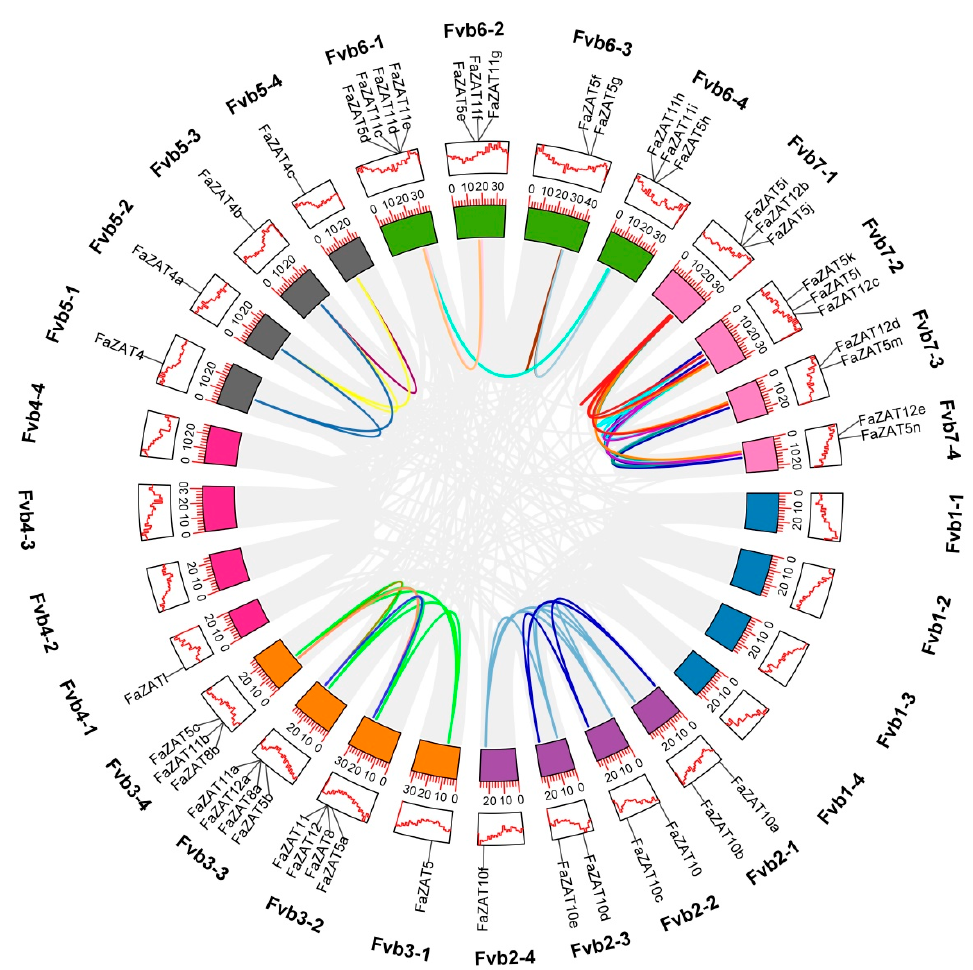
Figure 5. Synteny analysis of C2H2-ZFP C1-2i subclass in cultivated strawberry. Chromosomes are distinguished by different colors, the gray curve is the collinear gene region within the genome, and the colored curve is the collinear gene pair of the C2H2-ZFP C1-2i subclass.